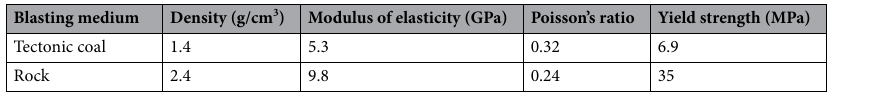
Table 2. Tectonic coal and rock parameters used in numerical